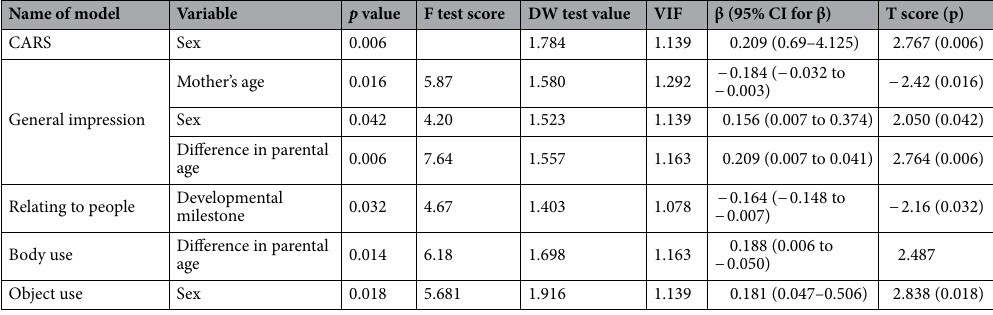
Table 5. Regression analysis